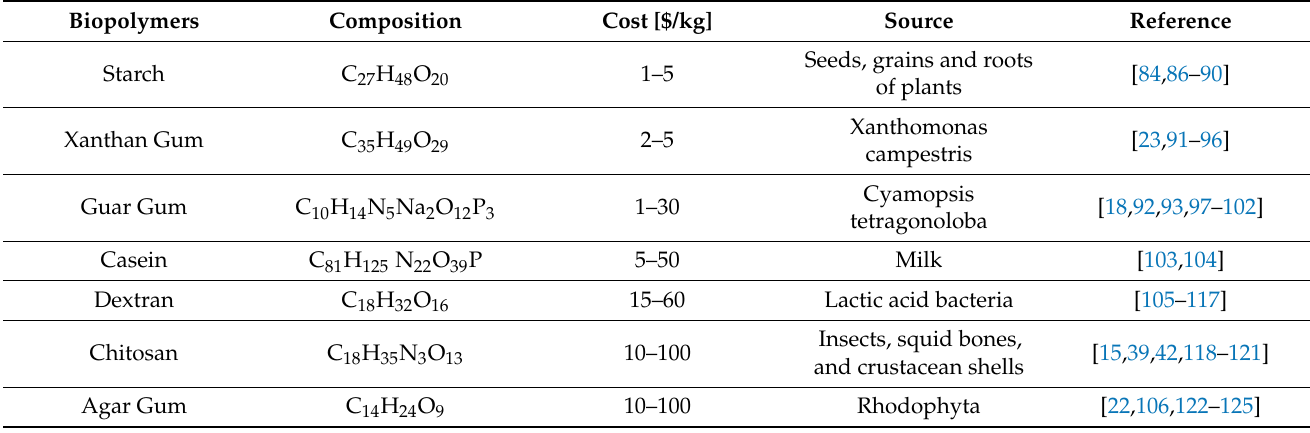
Table 1. Common biopolymers used in geotechnical engineering.